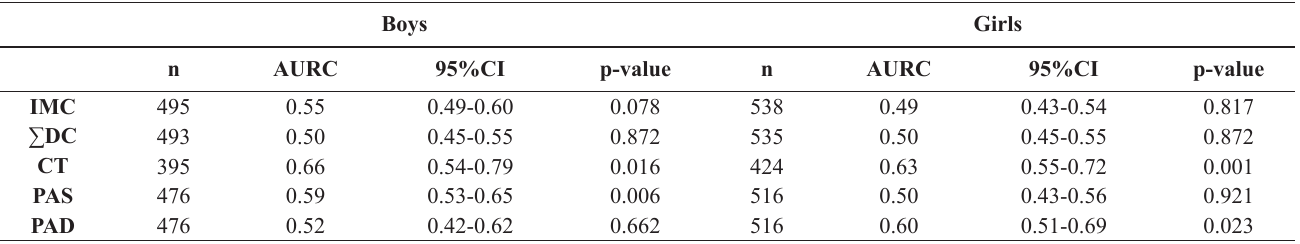
Table 3. Area under the ROC curve between number of steps/day and cardiovascular disease risk factors in adolescents of 11 to 17 years old in Uruguaiana, Rio Grande do Sul, Brazil,